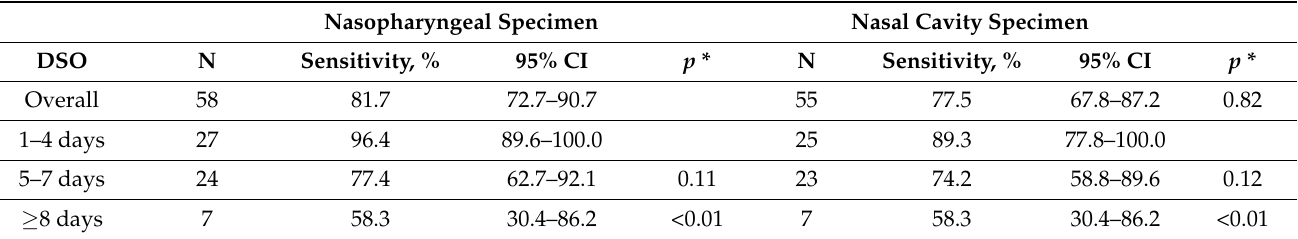
Table 3. Sensitivities of STANDARD Q COVID-19 Ag test according to time from symptom onset to sample collection